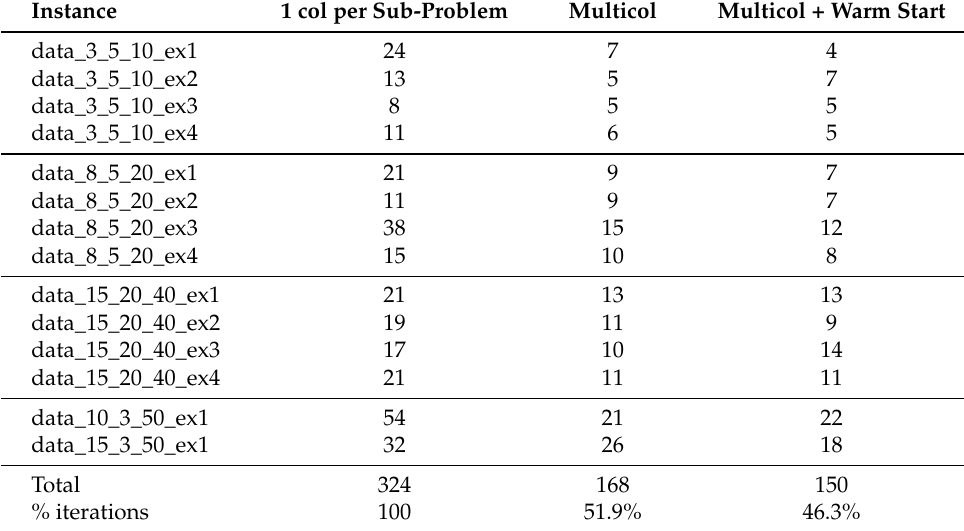
Table 7. Number of iterations for the convergence of CG algorithm to solve the LP relaxation of the extended formulation compared when only one column is generated per sub-problem, improvements with multi-column generation and providing an optimum of the MILP as the initial solution. Instance 1 col per Sub-Problem